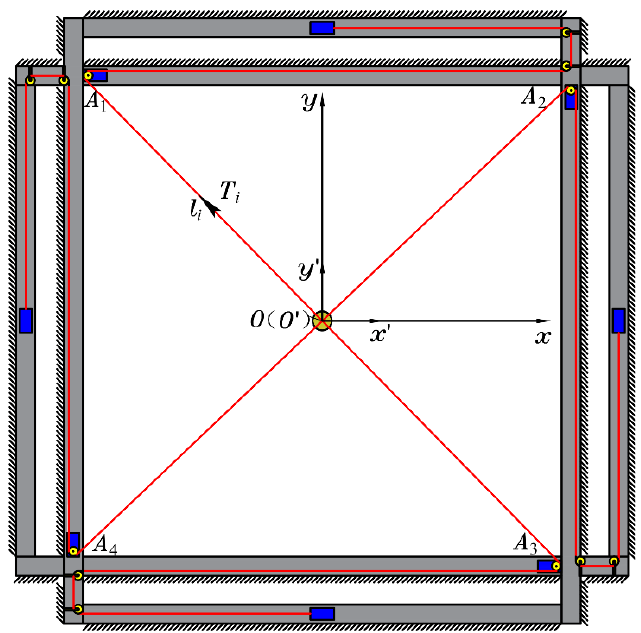
Figure 2. Model diagram of the four-cable-driven parallel mechanism.